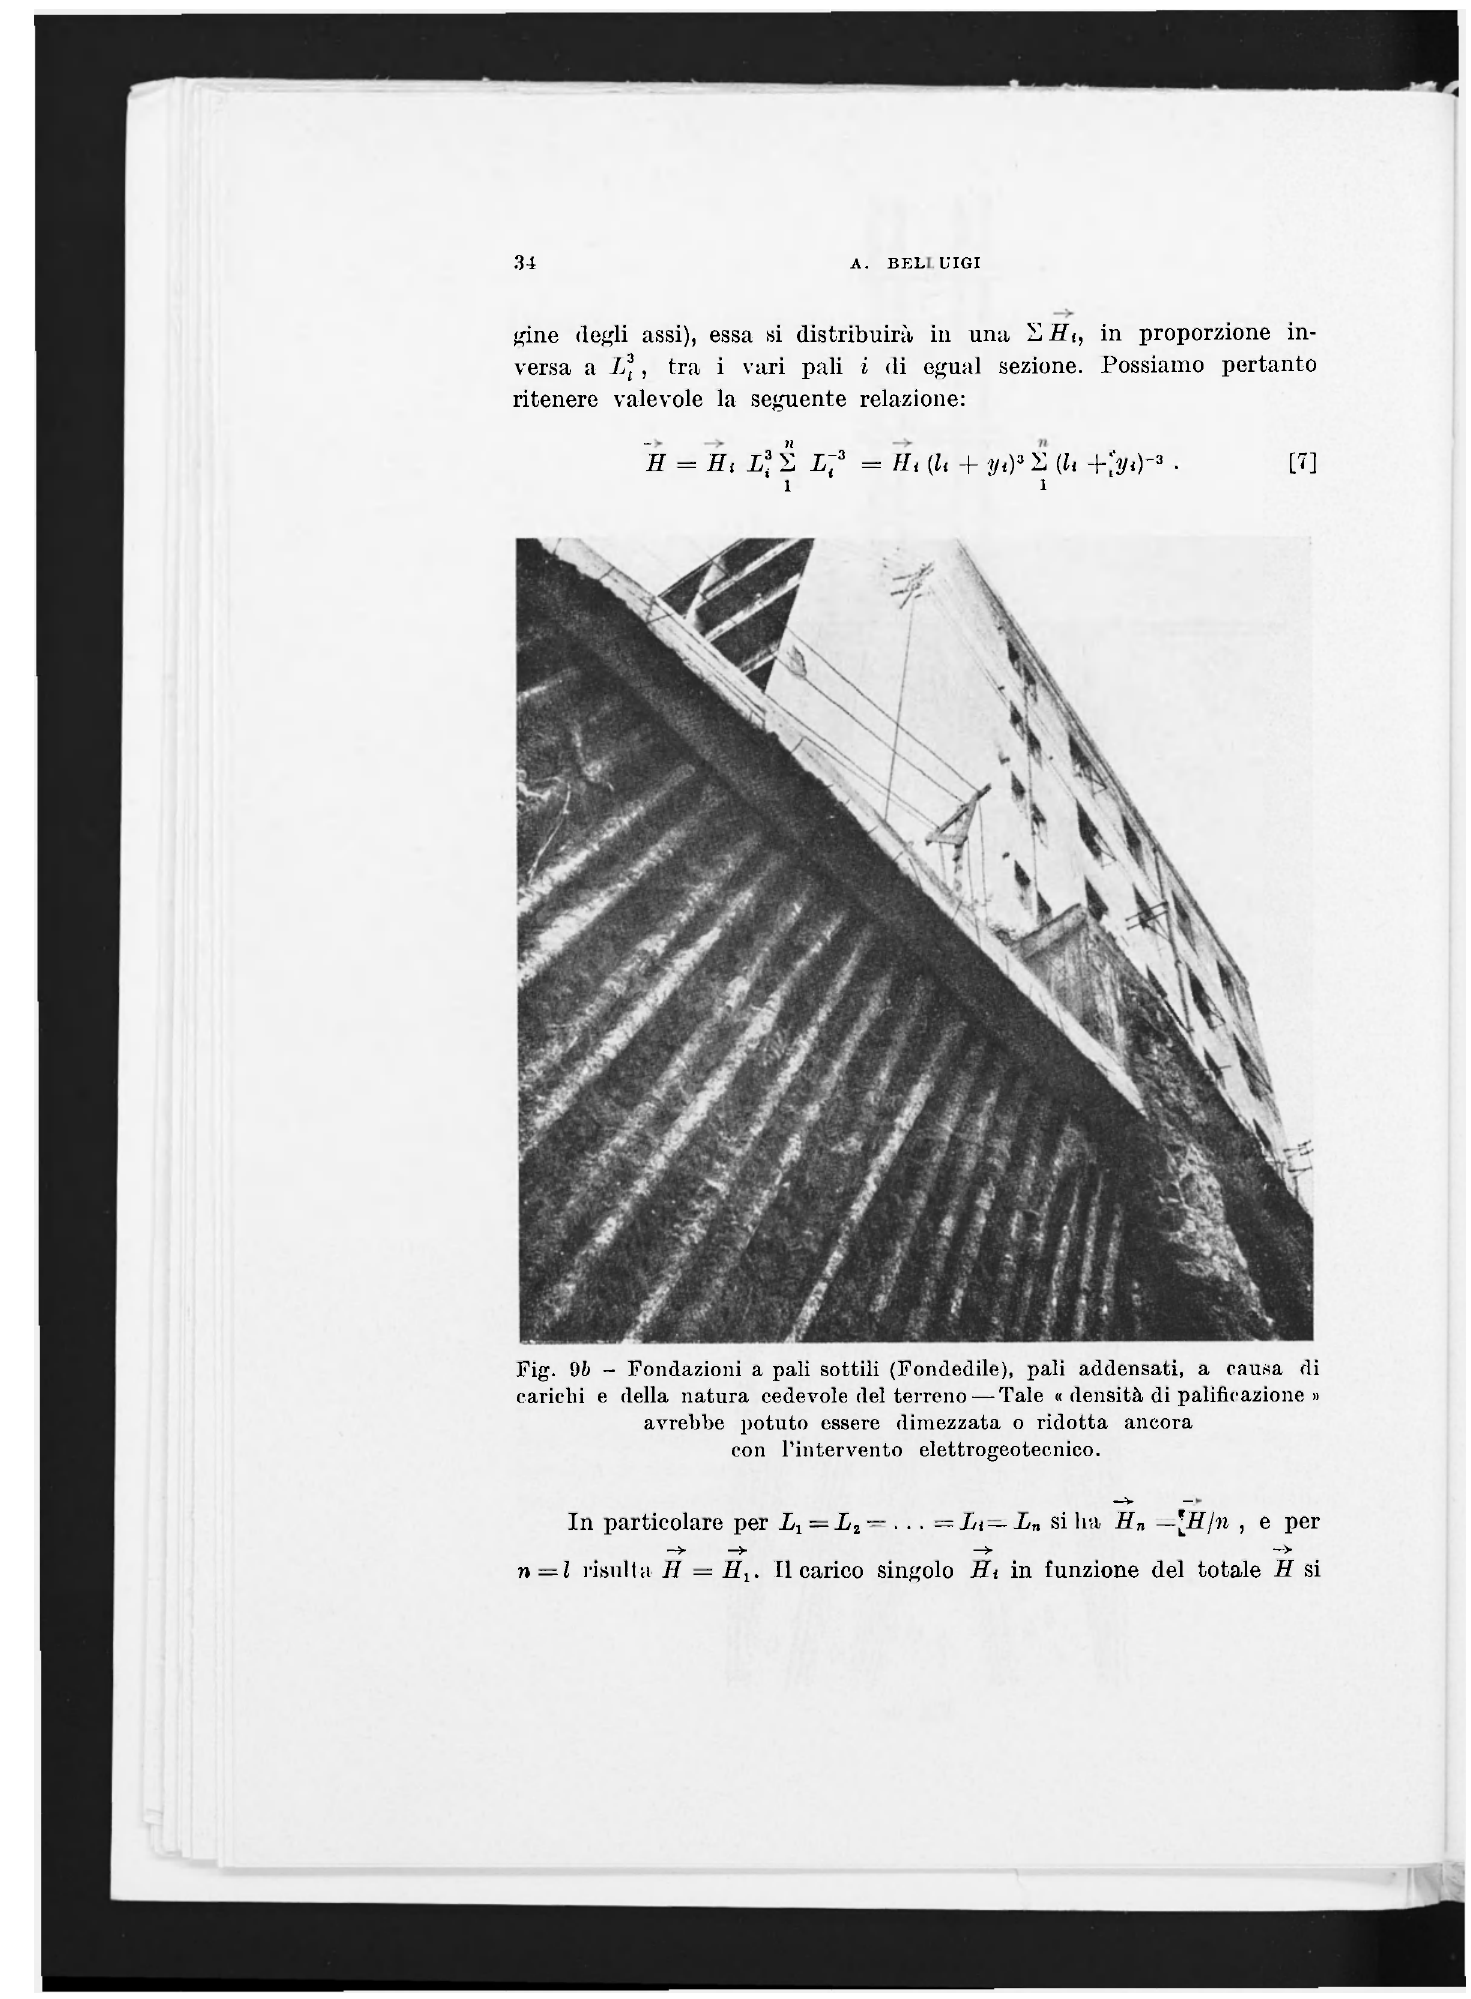
Fig. 96 - Fondazioni a pali sottili (Fondedile), pali addensati, a causa di carichi e della natura cedevole del terreno — Tale « densità di palificazione » con l'intervento elettrogeotec.nico. —=>- — In particolare per L 1 =L 2 — . .. = Li—L n si ha H n —\Hjri , e per - > - - »• —> -> n =1 risulta 77 = H l